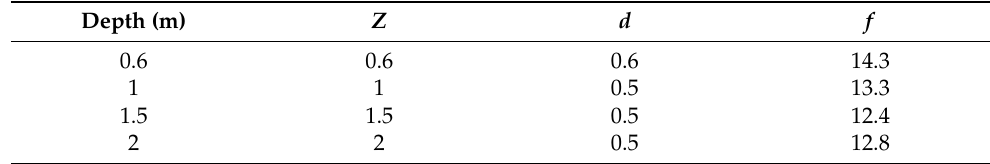
Table 1. Part temperature model parameters of Equation (4).